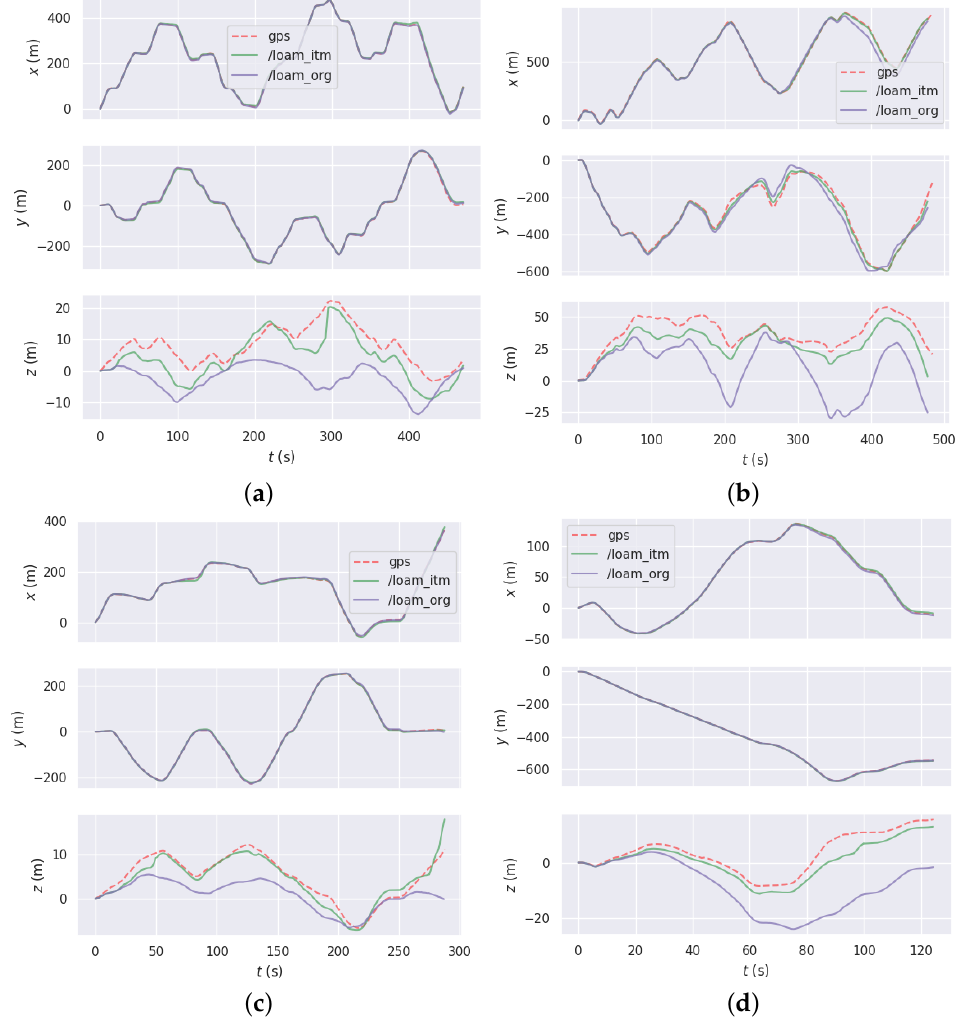
Figure 12. Comparison of Mapping Results with and without ITM Using KITTI Dataset. ( a ) KITTI Dataset 00. ( b ) KITTI Dataset 02. ( c ) KITTI Dataset 05. ( d ) KITTI Dataset